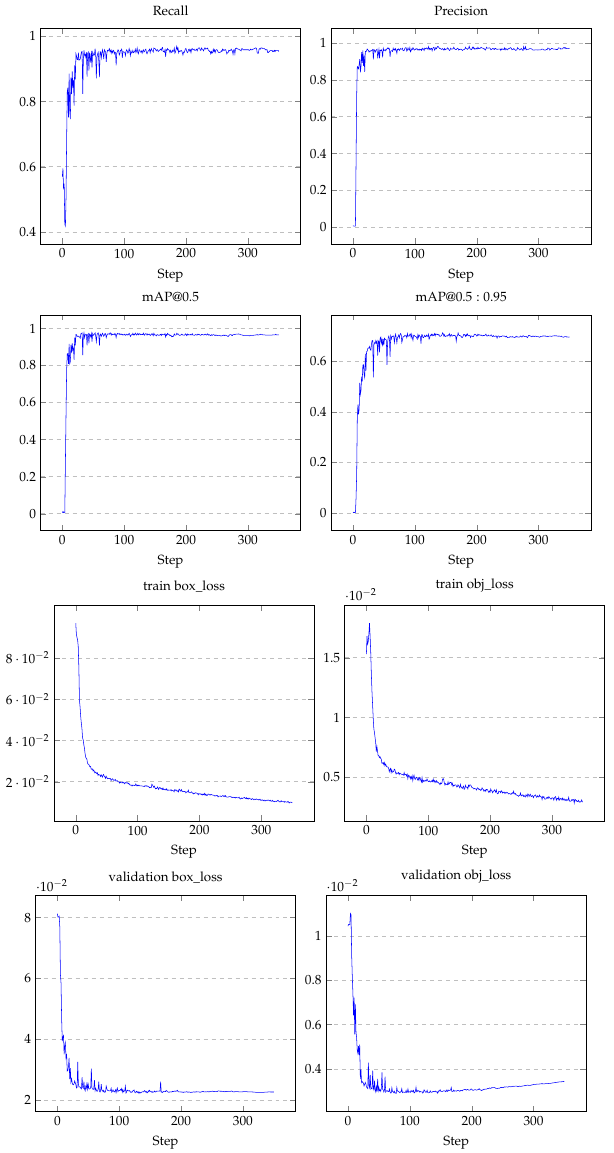
Figure A1. Evolution of the different metrics during the training of the prostate detection model. The figure contains the Recall, Precision, mAP@0., mAP@0.5 : 0.95, and both the object and box loss for the training and validation sets.